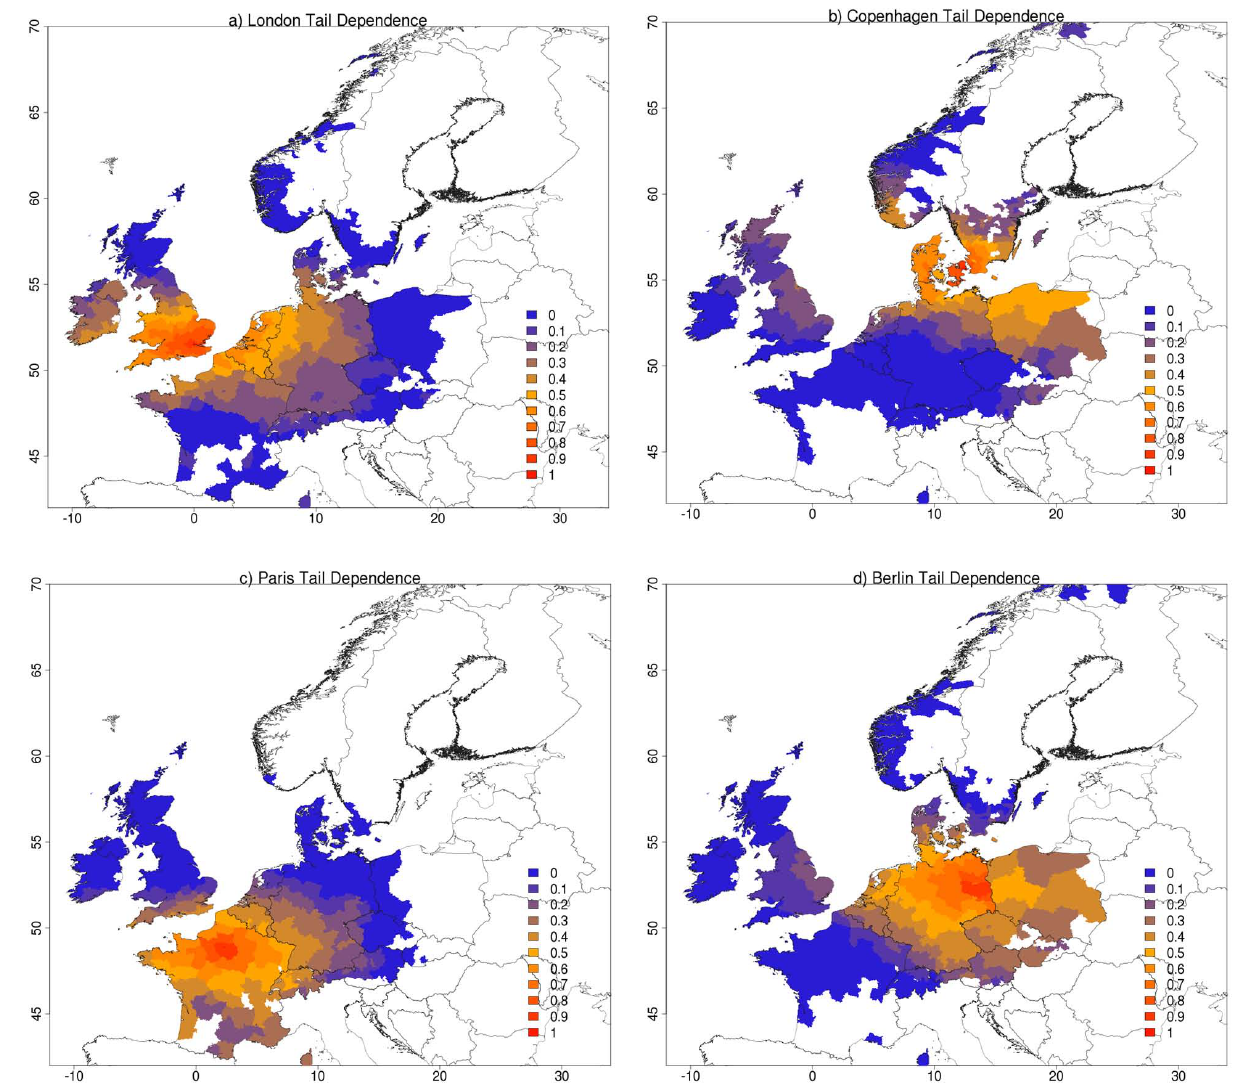
Fig. 5. Maps of tail dependence coefficients χ , centered in London (a) , Copenhagen (b) , Paris (c) , and Berlin (d) . Each map shows χ -values between selected cities and all other CRESTAs in the